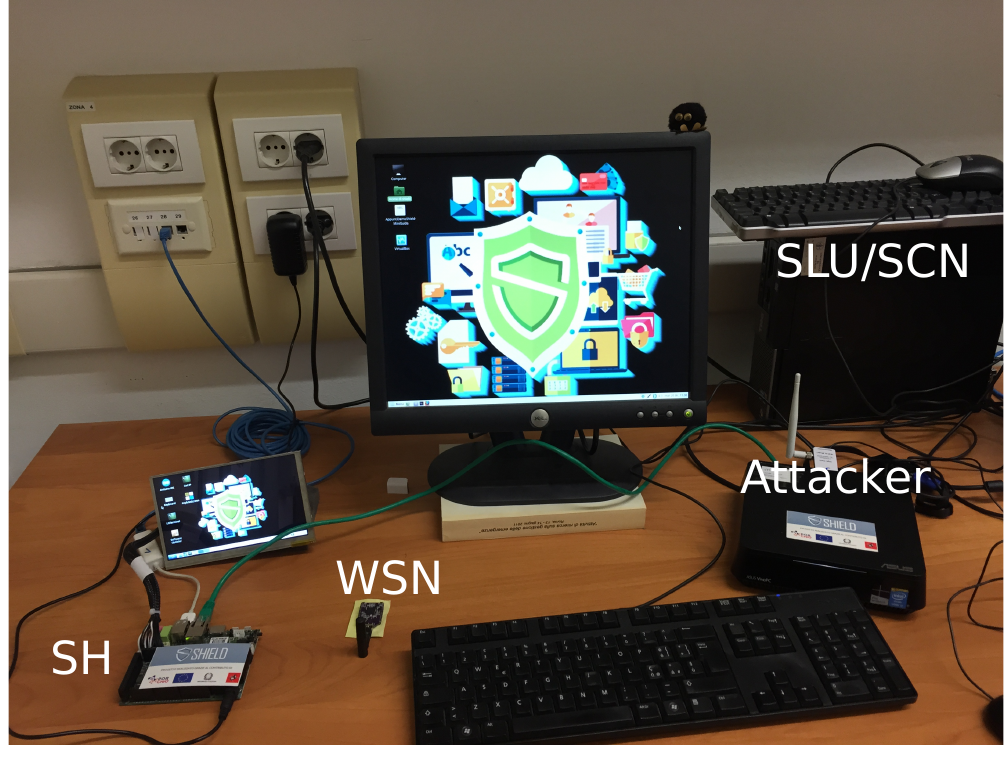
Figure 4. SHIELD test bed.